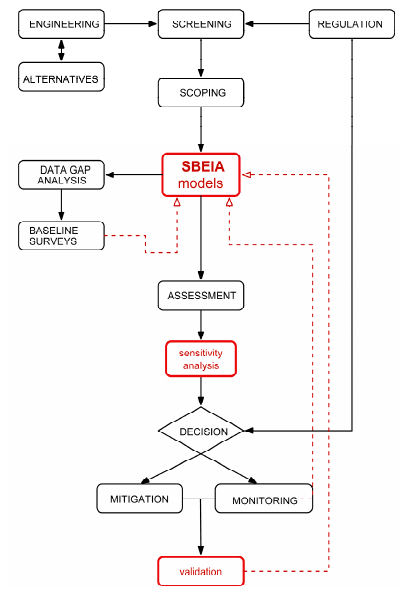
Figure 2. System-Based EIA (SBEIA) Workflow Chart.